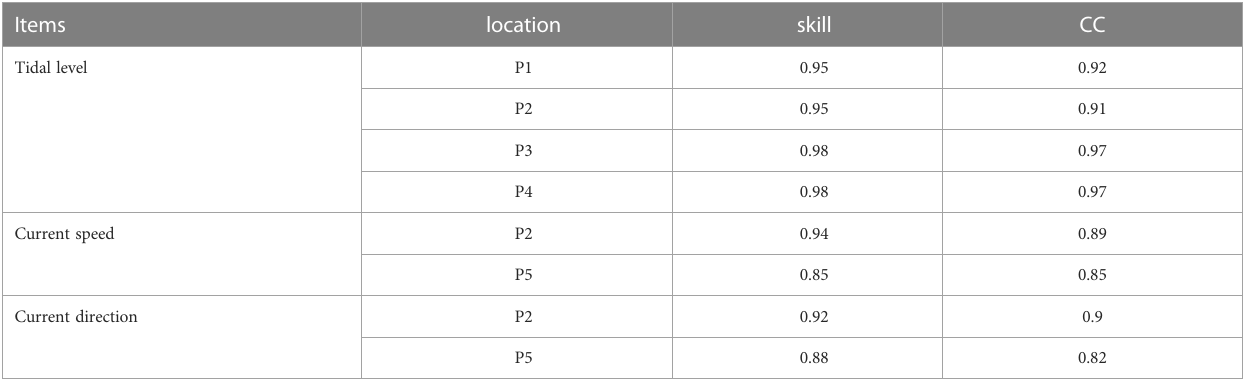
TABLE 1 Skill and CC value at each